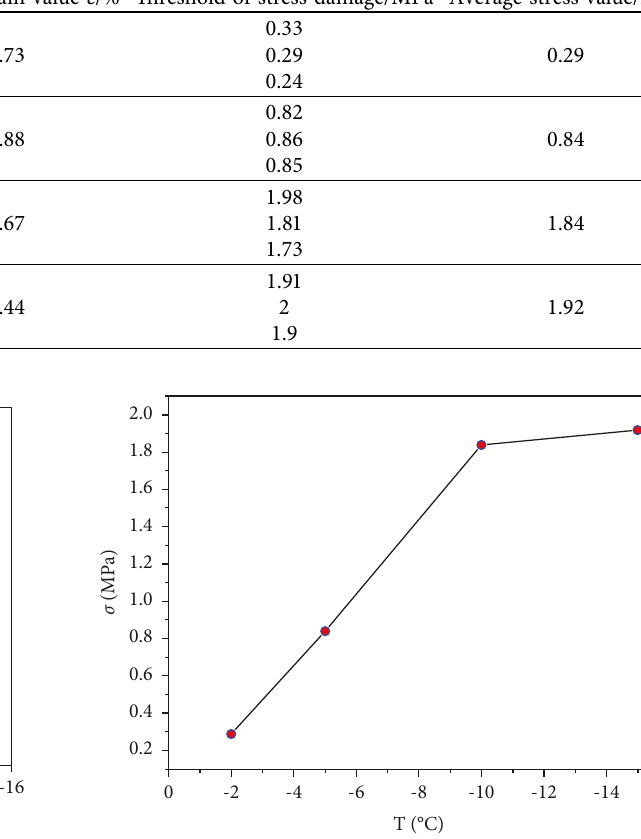
Figure 8: Threshold value of strain damage at different temperatures.